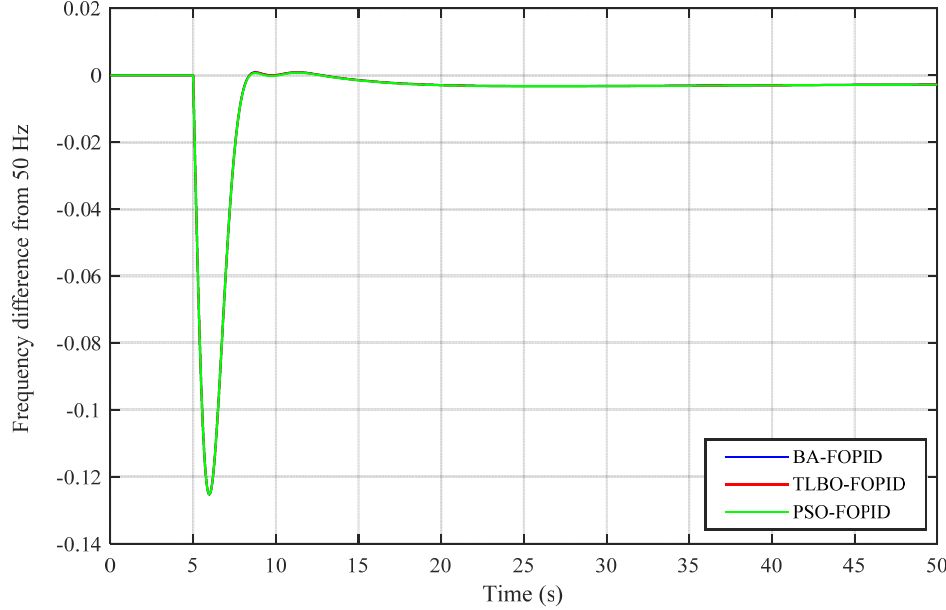
Figure 8. Change in frequency in the GB power system for 0.035 pu load disturbance with tuned FOPID-based ISE.